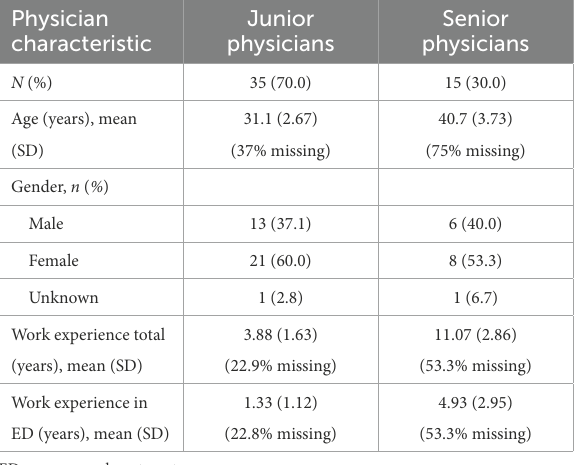
TABLE 2 Descriptive statistics for participating physicians ( N = 50).